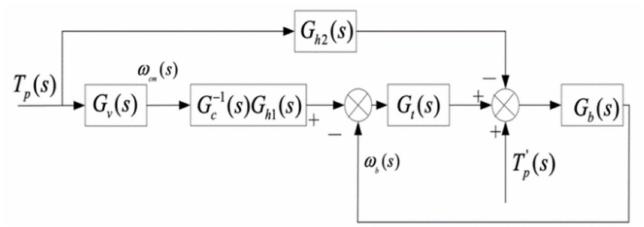
Figure 6. Transfer function diagram after adding the interference